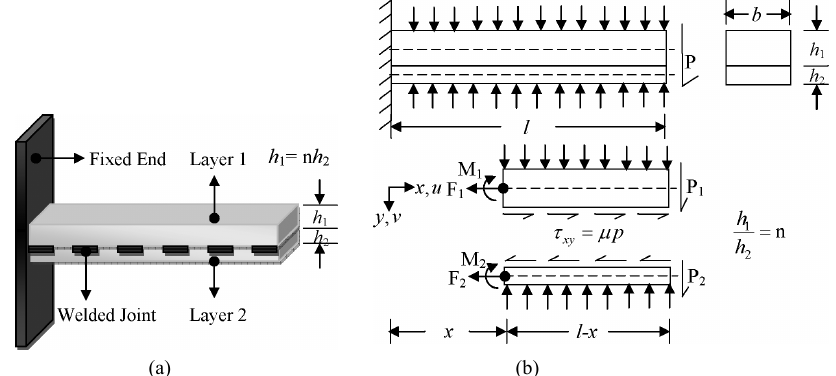
Fig. 1. (a) Two layered tack welded cantilever beam model; (b) Two halves of the beam depicting load and co-ordinates. contributes to the damping. They have also shown that the restoring force is developed by this adhesive medium and is proportional to the interfacial